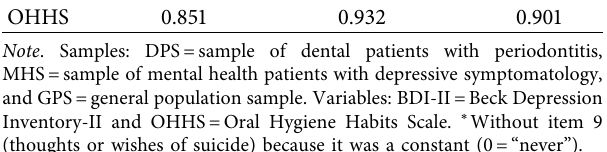
Table 1: Runs test for the randomness of the data sequence.